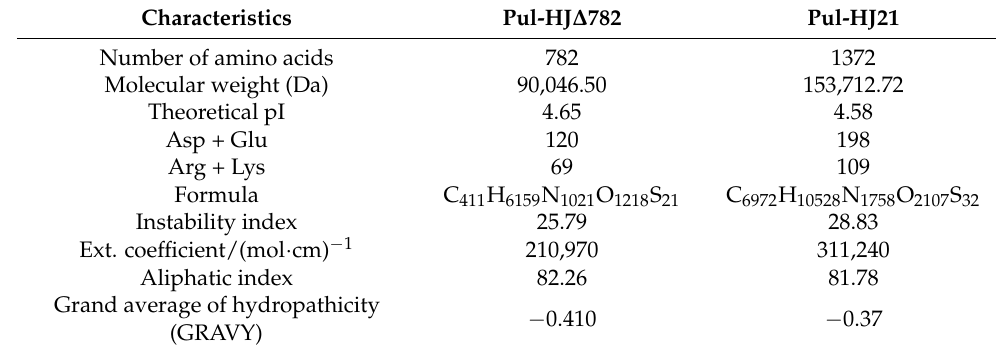
Figure 1. ( a ) Structural mode of Pul-HJ21. The green part shows the three-dimensional structure of Pul-HJ Δ 782; the red part indicates the deleted structure of Pul-HJ21; the blue color indicates the incomplete ( β / α ) 7 folded barrel structure of Pul-HJ Δ 782. ( b ) Structural mode of Pul-HJ Δ 782. The ( β / α ) 7 barrel domain is shown in orange, the double helix domain is shown in purple, and the C-terminal domain is shown in yellow. ( c ) Structural mode of Pul-HJ Δ 782. The ( β / α ) 7 barrel domain is shown in orange, the double helix domain is shown in purple, and the C-terminal domain is shown in yellow. Table 1. Comparison of the physical and chemical properties of truncated enzymes and Pul-HJ21.